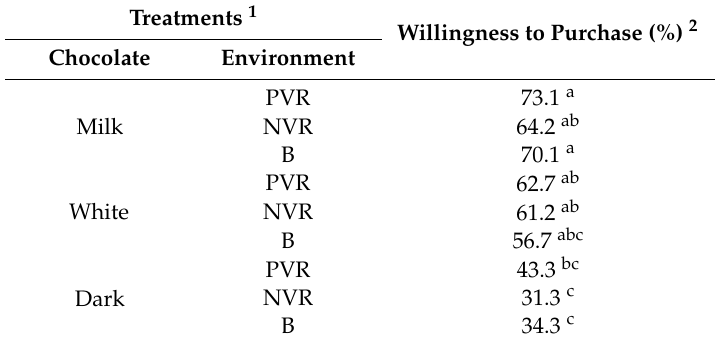
Table 1. Purchase intent frequencies of chocolate products under di ff erent environments. Treatments